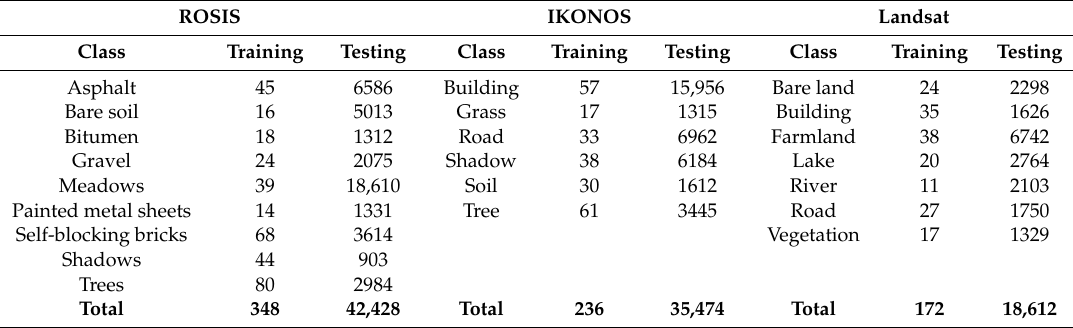
Table 1. The training and testing samples per class for the three study areas. ROSIS IKONOS